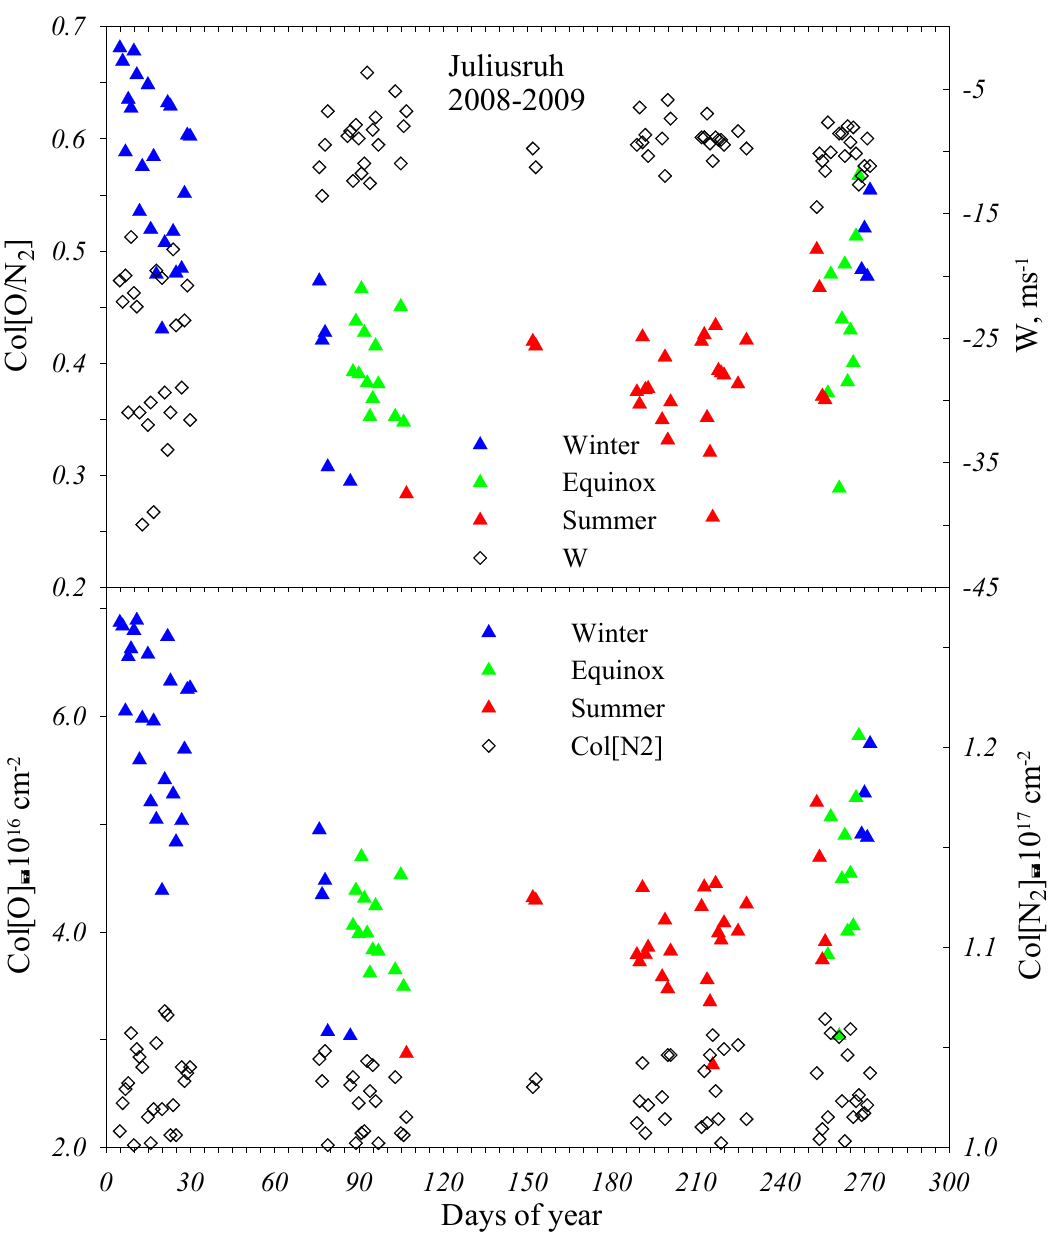
Figure 5. Seasonal variations of noontime column O/N 2 ratio at Juliusruh for days with well-pro- nounced winter, summer, and equinox foF 2 diurnal variations along with retrieved vertical plasma drifts, W (top panel). Bo tt om panel gives separately column [O] and [N 2 ] for the same dates.